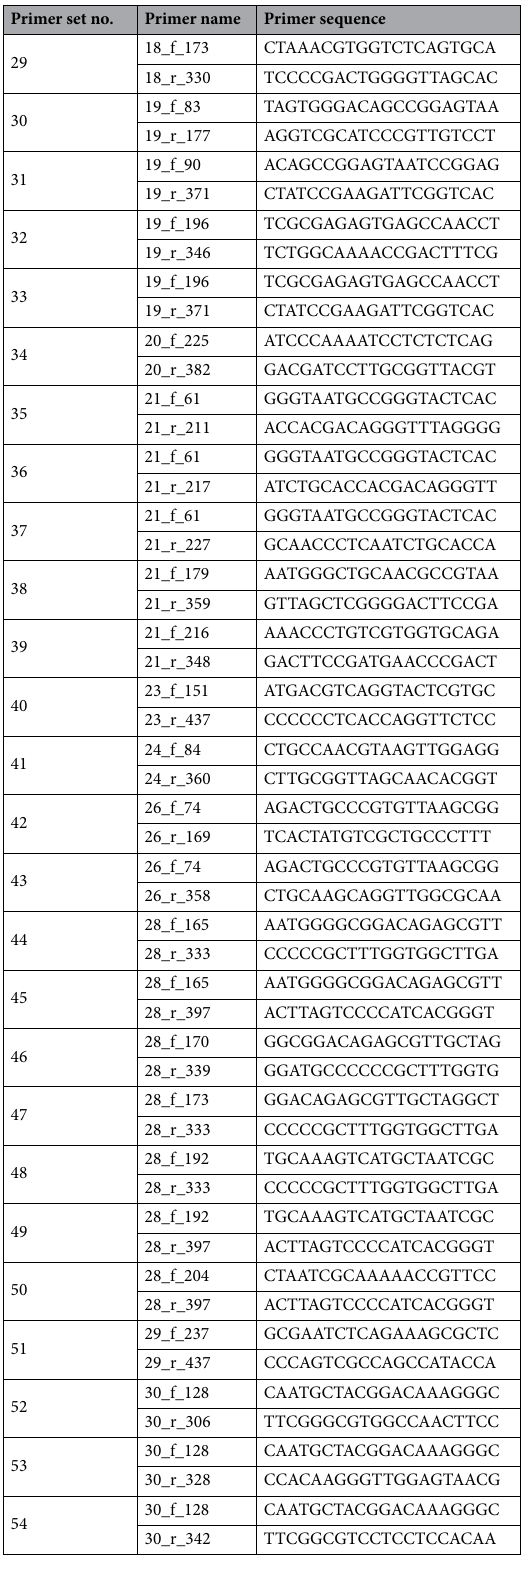
Table 2. Primer sets for the test. Primer pair number, primer name and base sequence (5 ′ - > 3 ′ ) used in the experiments for RNN-test are shown. Primers with the same primer pair number are used as a set of